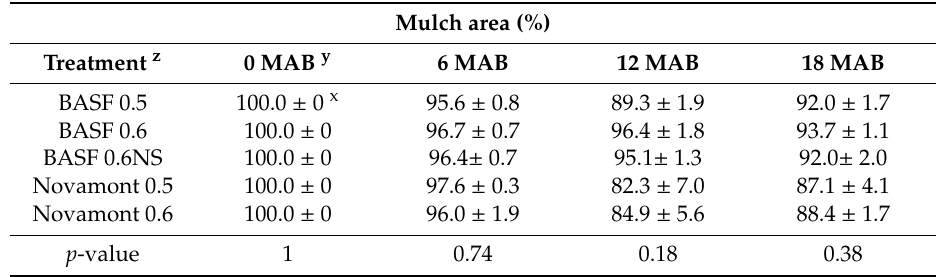
Table 4. Mulch area (%) of biodegradable plastic mulch (BASF and Novamont, where 0.5 and 0.6 indicate the film thicknesses: 0.5 mil = 12.7 µ m and 0.6 mil = 15.2 µ m) treatments prior to burial (0) and collected 6, 12, and 18 months after burial (MAB). Burial was in April 2018 in raised beds of a raspberry field at a depth of 10